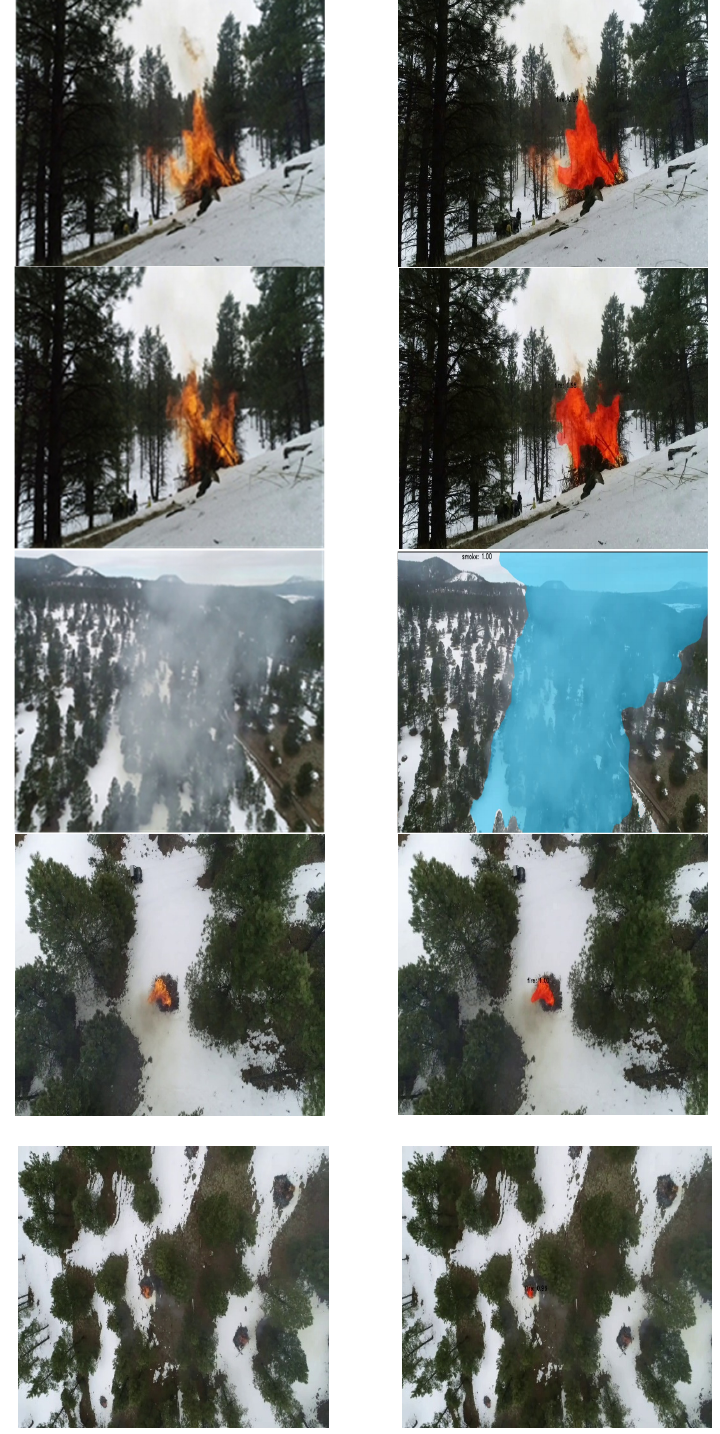
Figure A1. Results from FLAME dataset.